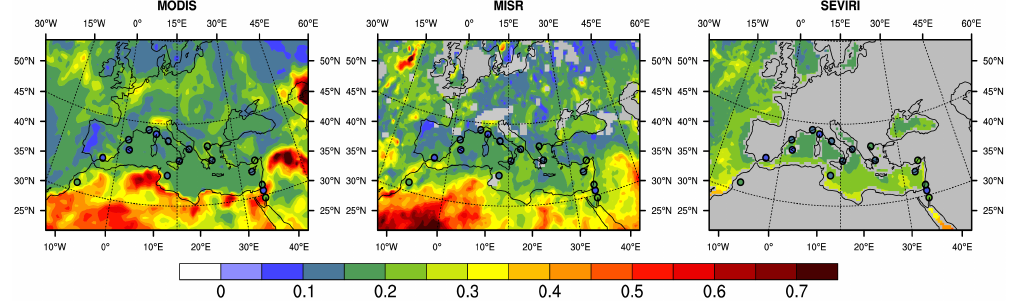
Figure 5. Total AOD (550nm) obtained from the MODIS, MISR and SEVIRI (sea only) sensors for the June–July 2013 period. The AERONET/PHOTONS AOD is also